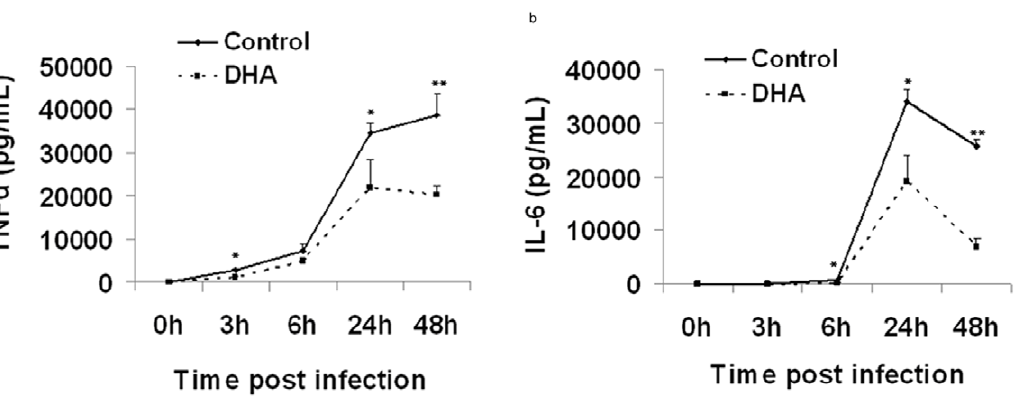
Figure 1. Suppression of TNF a and IL-6 by DHA in infected J774A.1 cells after IFN c treatment. Macrophages were incubated with 50uM DHA for 24 h and infected with M. tuberculosis for 1 h. Culture supernatants were quantified for TNF a and IL-6, as described in the Materials and Methods . Cells were originally seeded at a density of 250,000 cells/well. a. Quantitative data represent the concentration of TNF a and b. IL-6 post infection (pictograms per milliliter; mean 6 SEM; n=9).* Indicates a significant effect of DHA within the same interval compared to Control, * p , 0.05 ** p , 0.01. c. Representative histogram of the reduced IL-6 levels (lower intensity of fluorescence) in DHA-treated cells, compared to Control at 6 h post infection. The analysis was restricted to the fluorescent beads coated with antibodies to IL-6. Data are representative of three independent